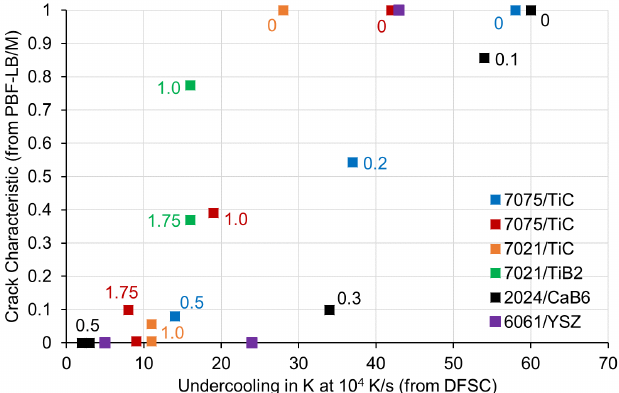
Figure 3. Correlation between crack characteristics C and solidification undercooling. Data points are labelled with the belonging nanoparticle amounts in mass %. Relative crack characteristics of 2024/CaB 6 and 6061/YSZ have been calculated from [11,13].